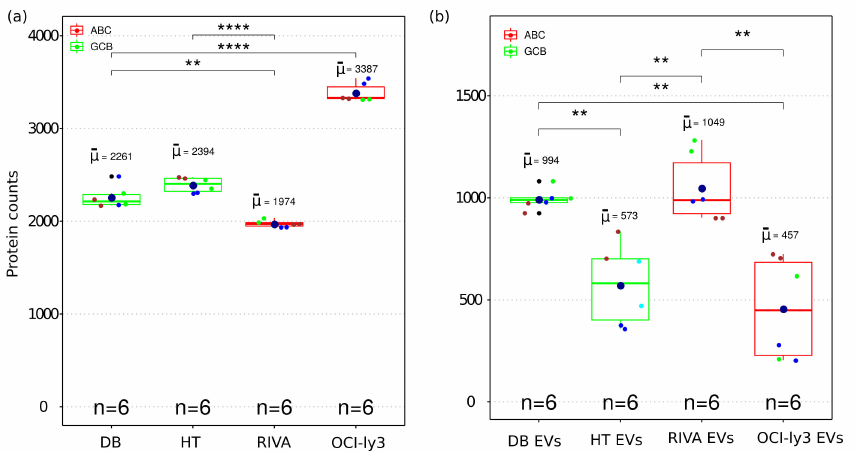
Figure 2. Boxplot of the number of identified proteins in whole cell ( a ) and EV ( b ) proteome from four DLBCL cell lines representing GCB and ABC sub types. The boxes indicate the median, second and third quartile. Mean values are represented by the large dark blue circles, while data points representing individual LC-MSMS runsare represented by smaller circles. All biological replica are depicted by a different small circle color and technical replica by identical small circle color. (**) correspond to p -value <0.01. (****) correspond to p -value <